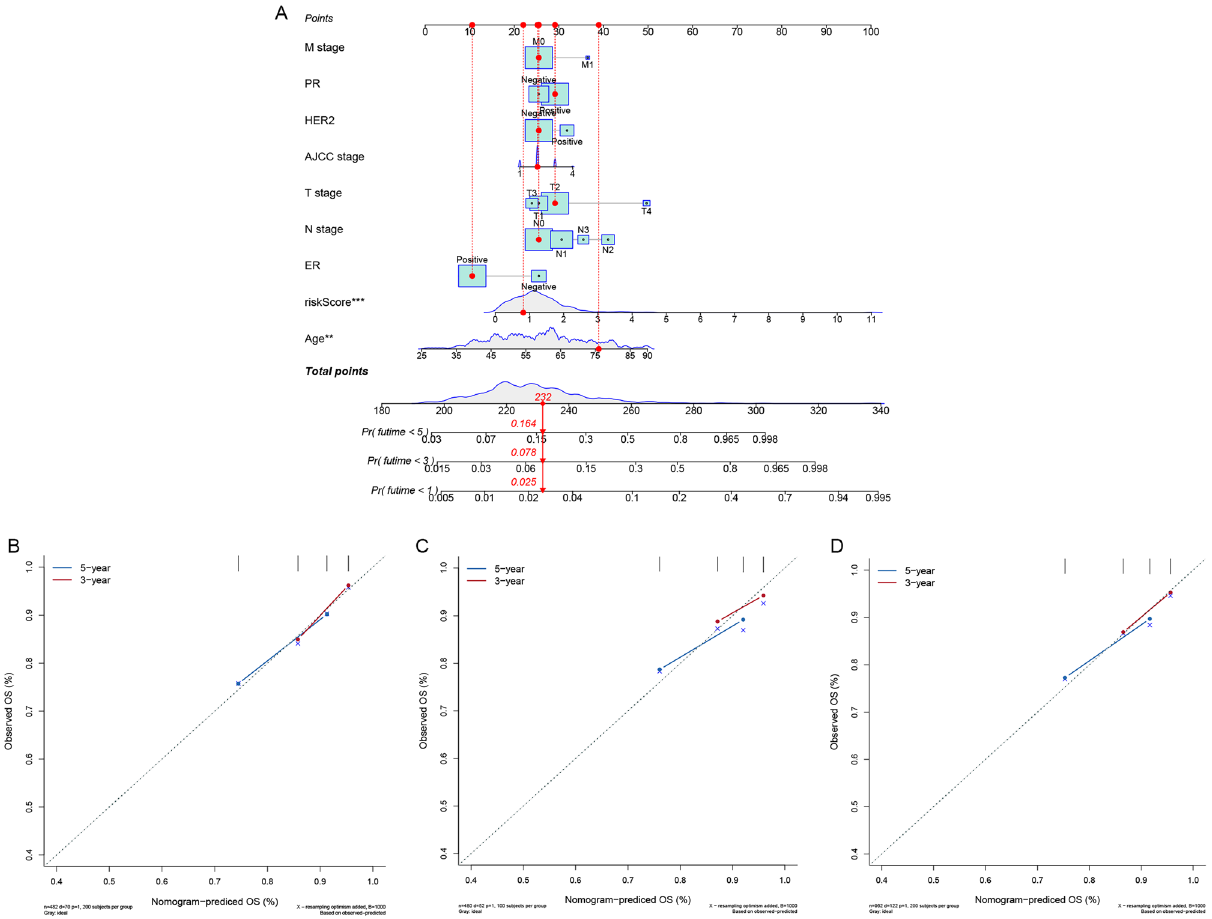
Figure 4. Establishment of the nomogram. ( A ) A nomogram established by integrated traditional clinicopathological indicators and the risk score. Calibration plots for 3- and 5-year OS in the training cohort ( B ), validation cohort ( C ), and entire cohort ( D